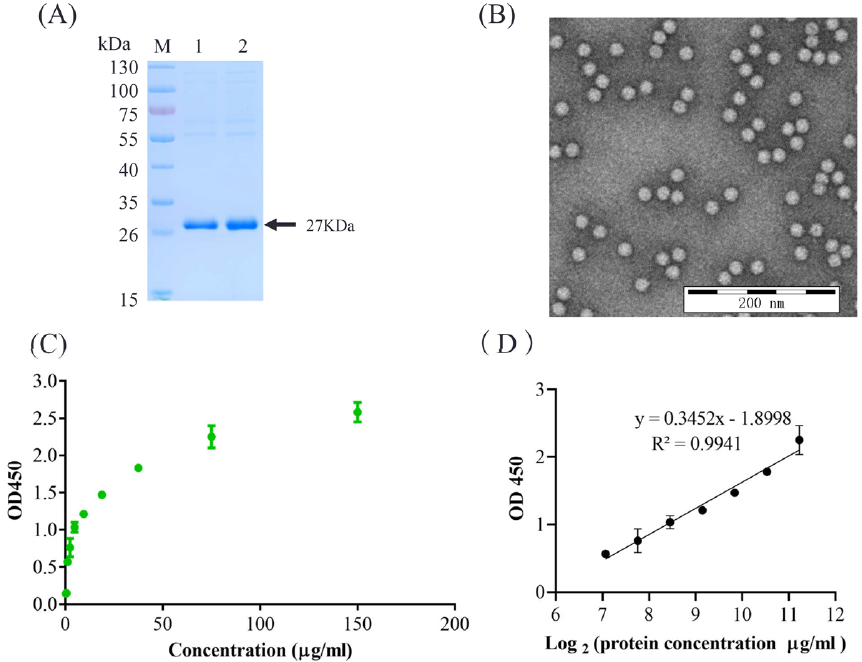
Figure 2. The standard PCV2 VLPs references and the optimized ELISA. The purified VLPs were tested by SDS-PAGE ( A ) and TEM analysis ( B ). The reference VLPs were two-fold diluted with concentration at 150, 75, 37.5, 18.75, 9.375, 4.688, 2.344, 1.171, 0.589, and 0.293 µ g/mL and analyzed by the optimized sandwich ELISA assay. Error bars represent standard deviation (N = 3). ( C ) OD450 and the concentrations were shown in the standard curve. ( D ) OD450 value and the Log 2 (concentration) were calculated as the linear equation. The standard curve y = 0.3452x − 1.8998 with an accept- able correlation coefficient of 0.9941 (R2). The data represent the mean standard deviation from triplicate